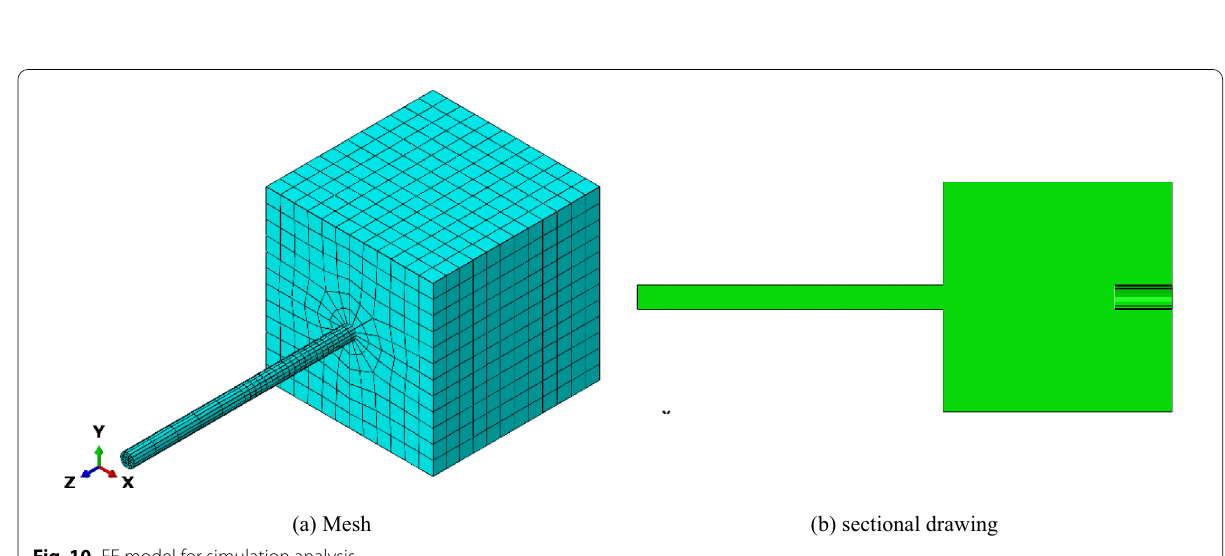
Fig. 10 FE model for simulation